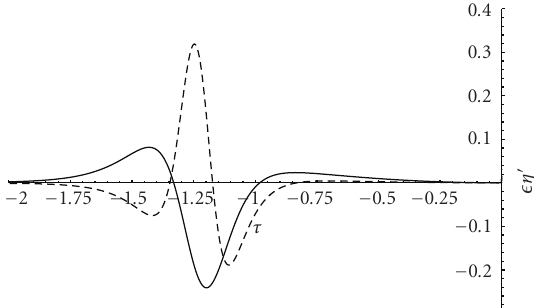
Figure 6: Behavior of the slow-roll parameters for a step (solid line, c = 0 . 0018, d = 0 . 022 M P ) and bump (dashed line, c = 0 . 0005, d = 0 . 01 M P ) sharp feature on (1 / 2) m 2 φ 2 potential. Note that in the absence of the sharp feature, (cid:2) η (cid:3) is of order O (10 − 4 ).